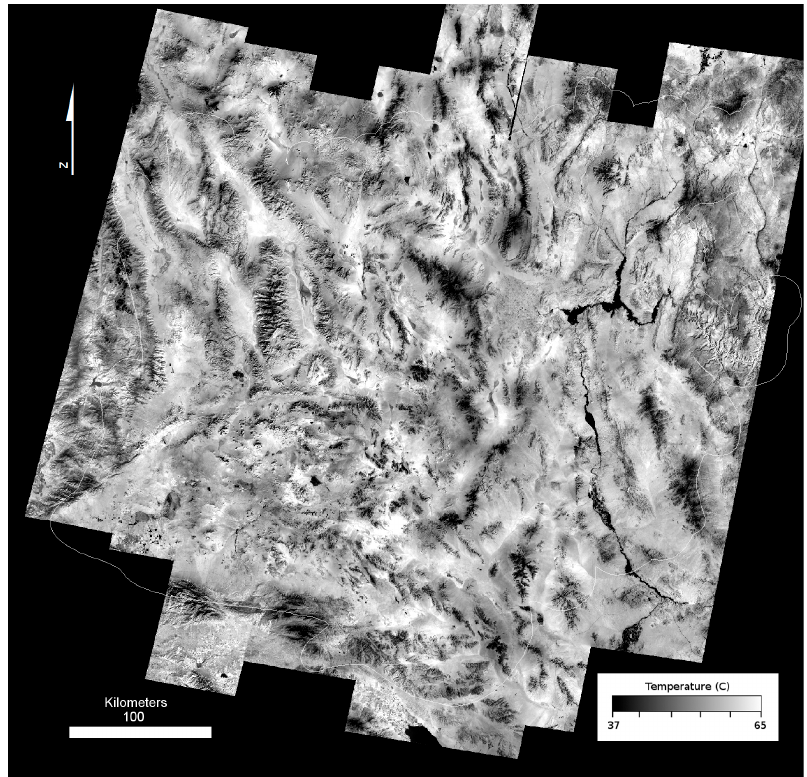
Figure 6. Daytime ASTER enhanced Land Surface Temperature (eLST) mosaic.